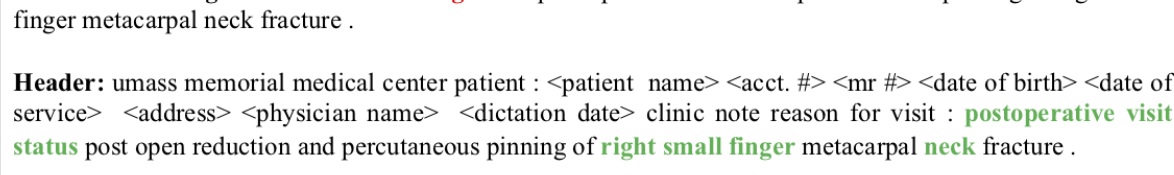
Figure 2. Example for model